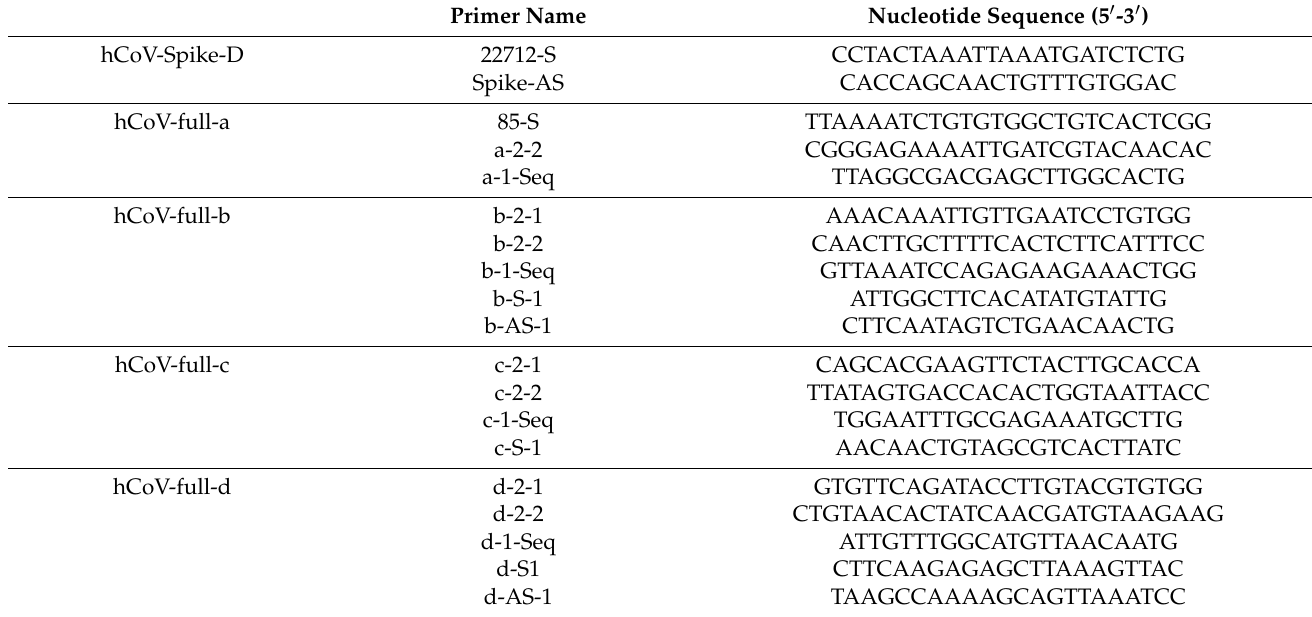
Table 2. In-house-developed primer library used for sequence analysis of SARS-CoV-2